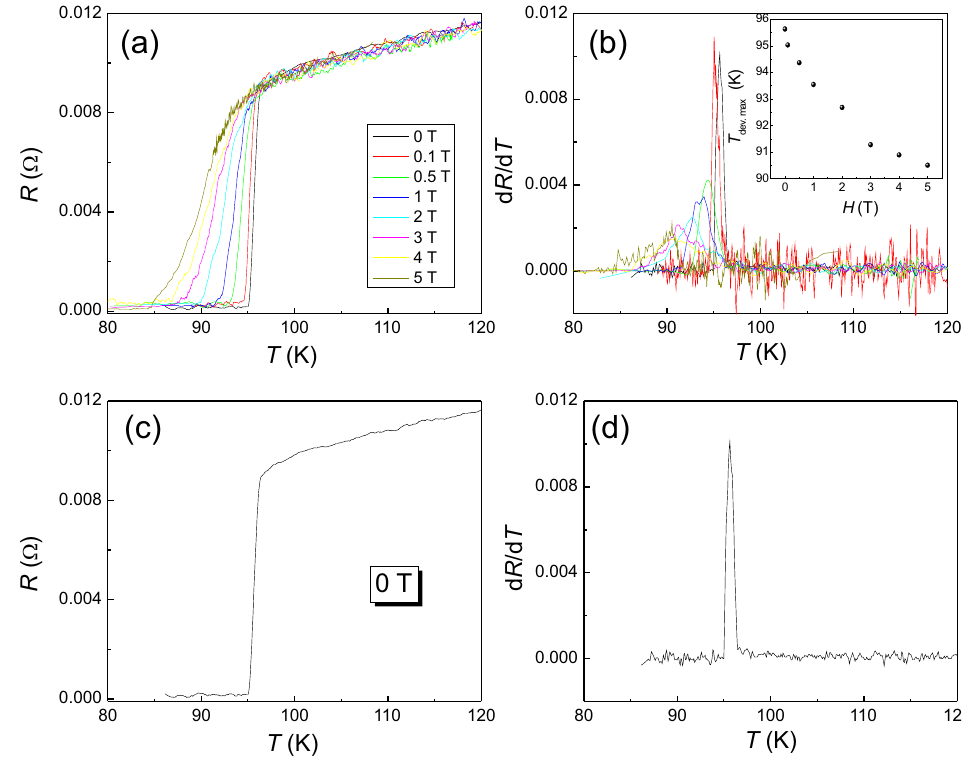
Figure 2. ( a ) Resistance vs. temperature of a melt-textured YBCO bulk prepared using the infiltration growth process in various applied magnetic fields. ( b ) The derivative d R /d T as function of T . The inset gives the maxima of d R /d T vs. the applied magnetic field. ( c ) The zero-field resistance curve and ( d ) d R /d T vs. T , illustrating the basic concept of the Roeser–Huber